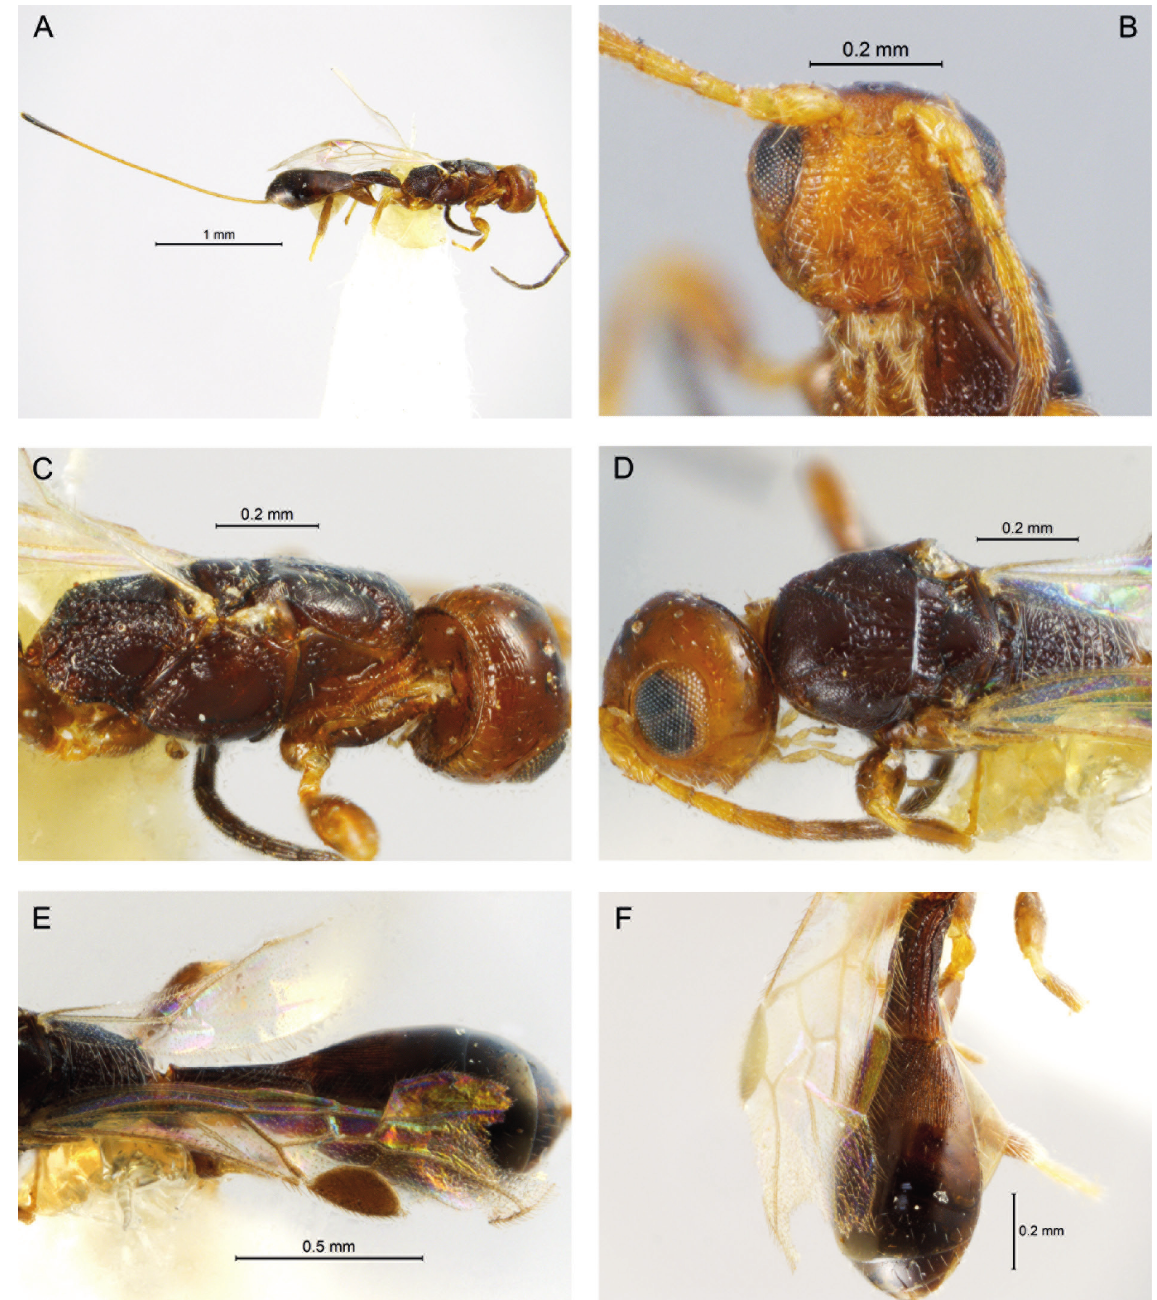
Fig. 3. Hecabolus gavinbroadi sp. nov., ♀, holotype (NHMUK). A . Habitus, lateral view. B . Head, frontal view. C . Mesosoma, lateral view. D . Mesosoma, dorsal view. E . Fore and hind wings, showing the wide pterostigma. F . Metasoma, dorsal